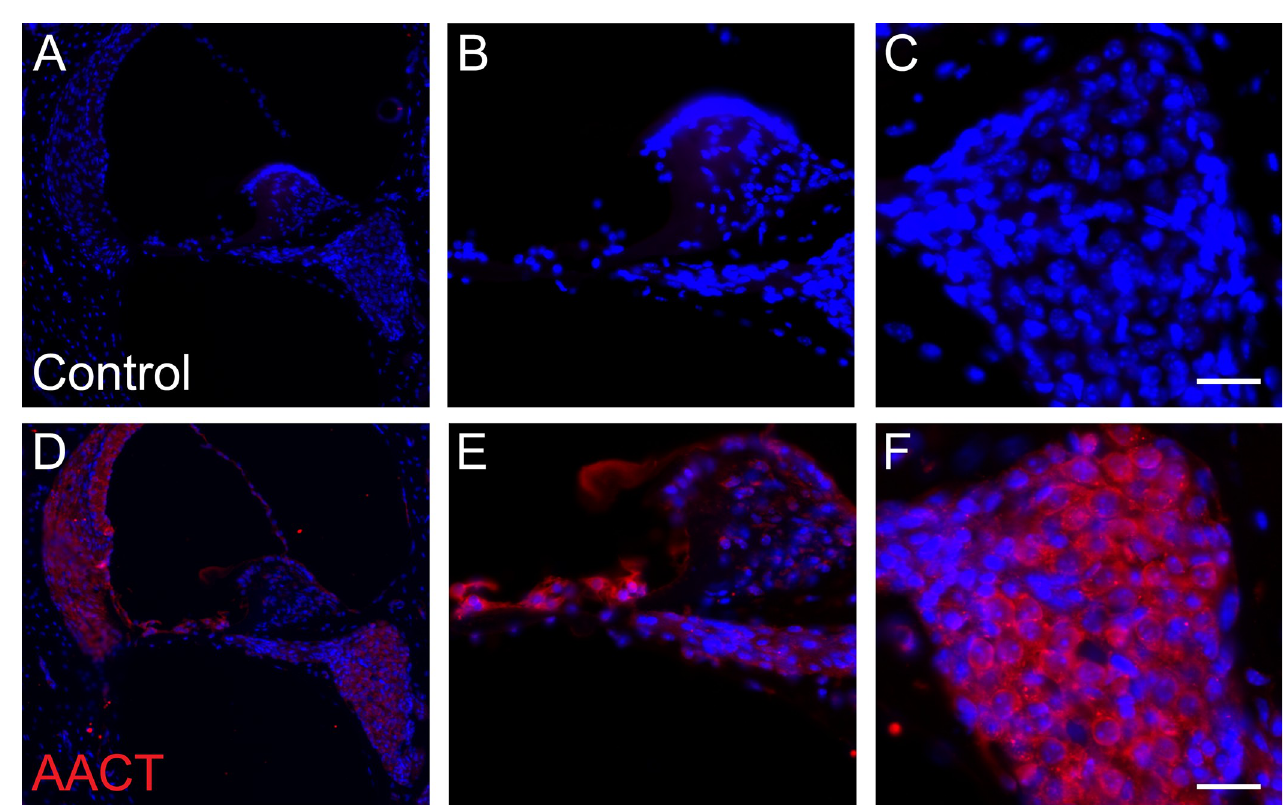
Fig 4. Immunohistochemical validation of AACT protein expression in the murine cochlea. ( A-C ) Negative controls were carried out without primary antibodies for AACT. Panel B shows a magnified view of panel A focusing on the organ of Corti including inner and outer cell cells. Panel C shows a magnified view of spiral ganglion cells. ( D-F ) Immunofluorescent staining of AACT protein (pseudocolored red) demonstrated widespread expression in the cochlea, including spiral ligament and stria vascularis. Panel E shows a magnified view of panel D focusing on the organ of Corti. Panel F demonstrates a magnified view of spiral ganglion cells. Cell nuclei were counterstained with DAPI (pseudocolored blue). Scale bars, 25 μ m.